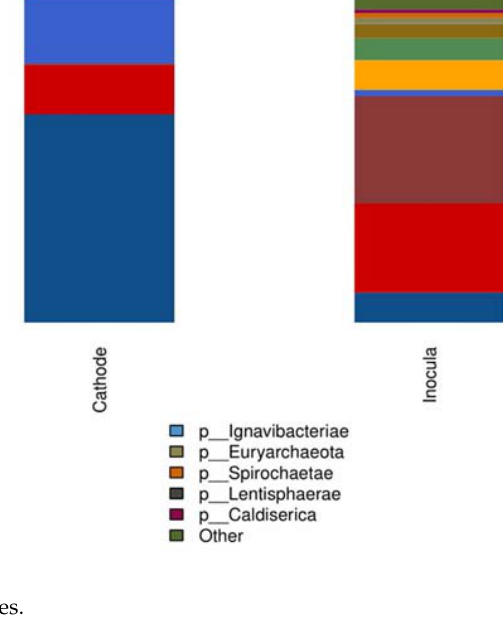
Figure 3. Phylum ‐ level microbial communities. Figure 3. Phylum-level microbial